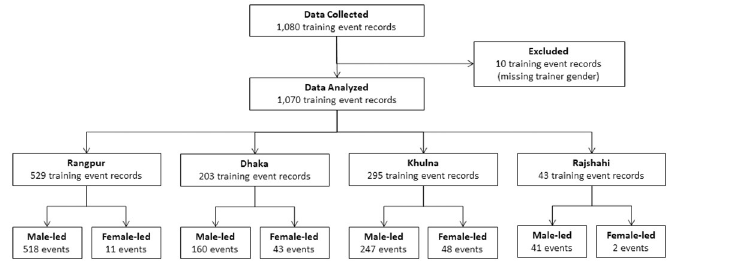
Fig 2. Research design and